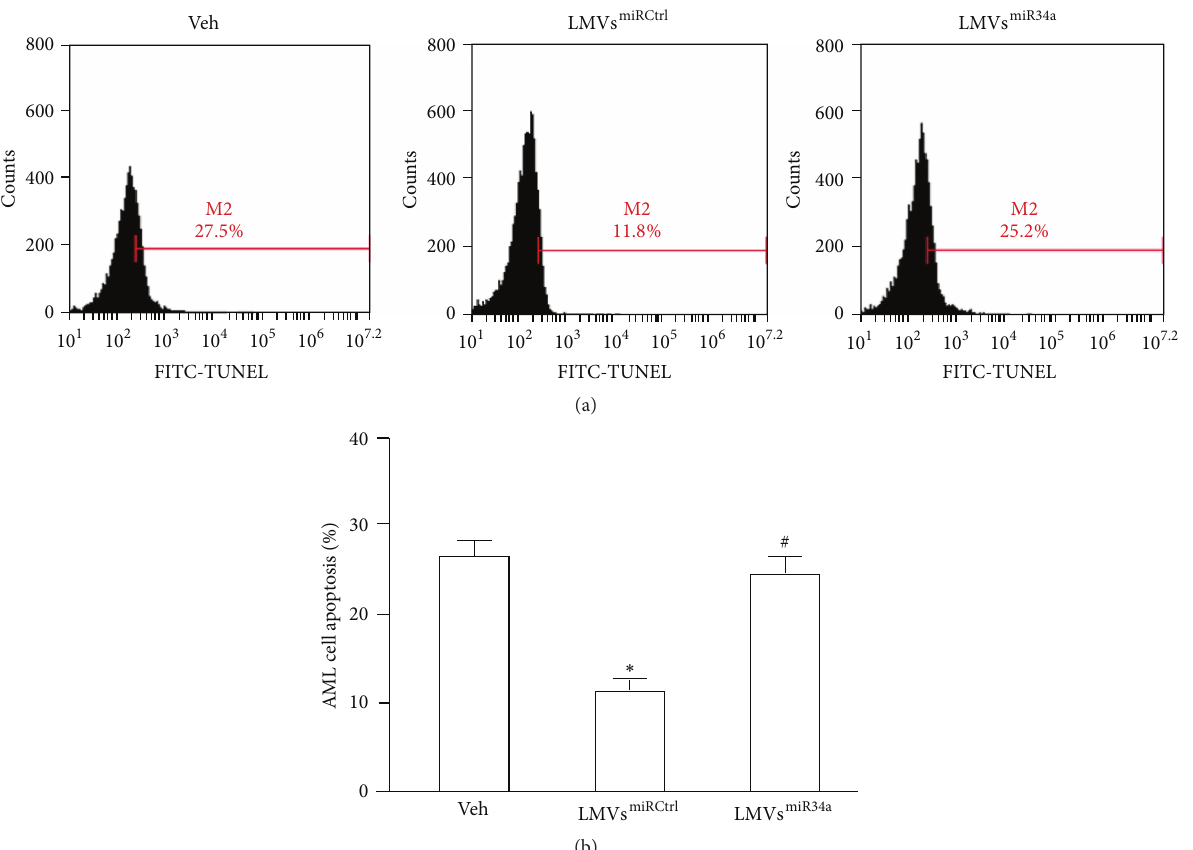
Figure 3: Effects of LMVs miRCtrl and LMVs miR 34 a on AML cell apoptosis. (a) Representative flow cytometric plots of AML cell apoptosis (percentage of FITC-TUNEL positive cells) after coincubation with veh, LMVs miRCtrl , or LMVs miR 34 a . (b) Summarized data of AML cell apoptosis. Data represents mean ± SEM. ∗ 𝑃 < 0.05 versus veh; # 𝑃 < 0.05 versus LMVs miRCtrl . Veh: fresh culture medium; LMVs miRCtrl : LMVs generated from miRCtrl transfected LSCs; and LMVs miR 34 a : LMVs generated from miR34a mimic transfected LSCs.